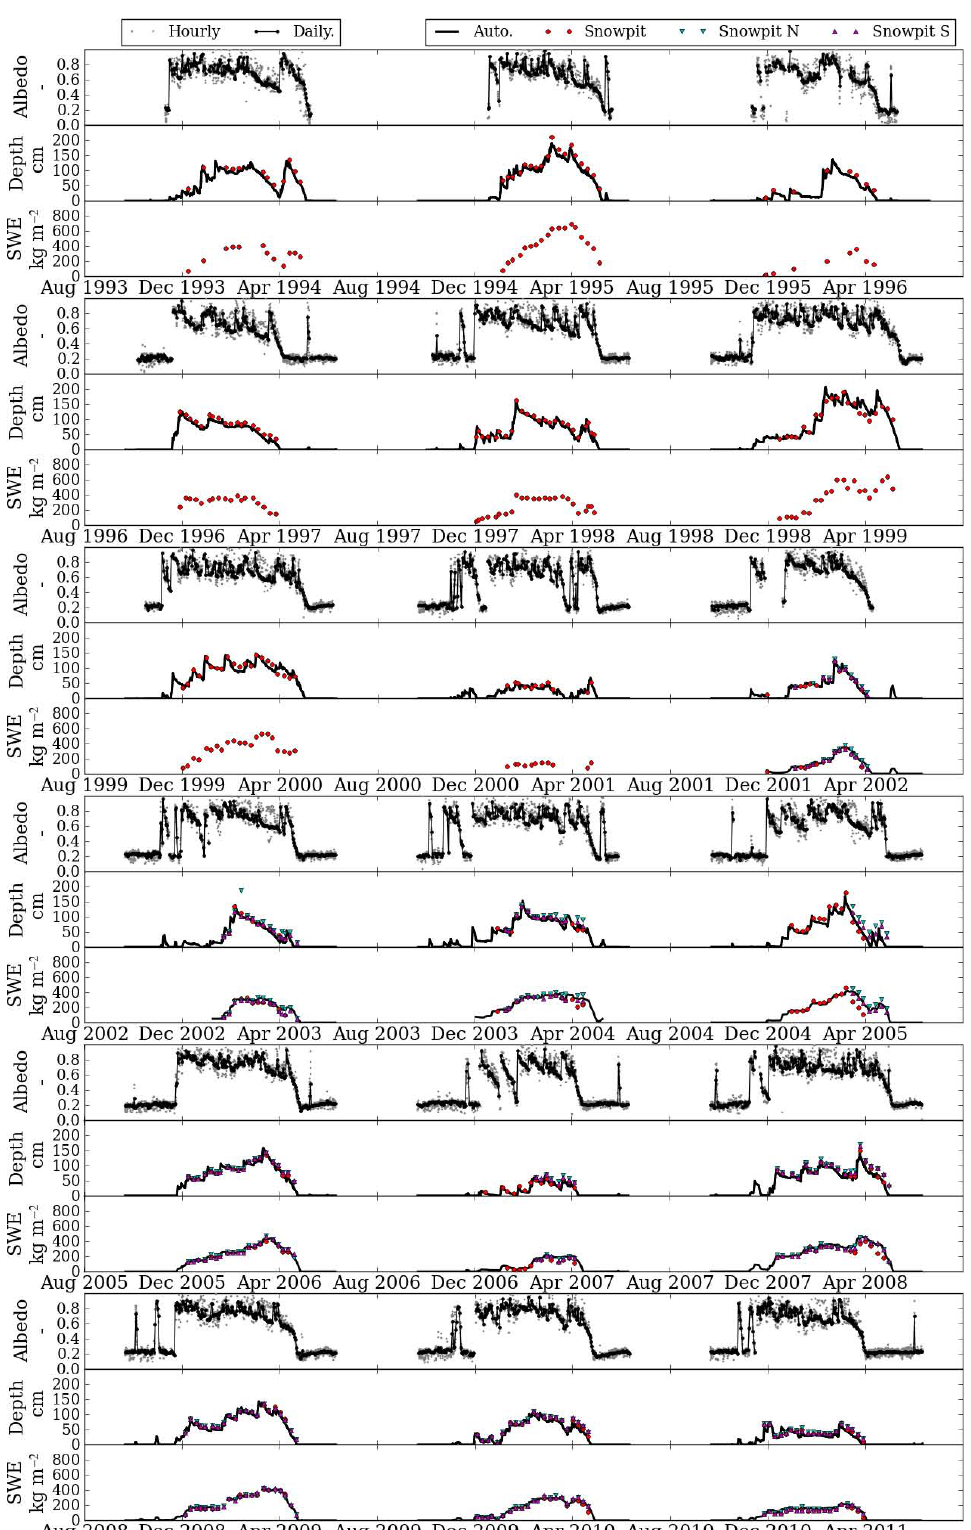
Figure 5. Overview of the snowpack albedo, depth and SWE for the entire record. Yearly graphs are provided as Supplement online material.